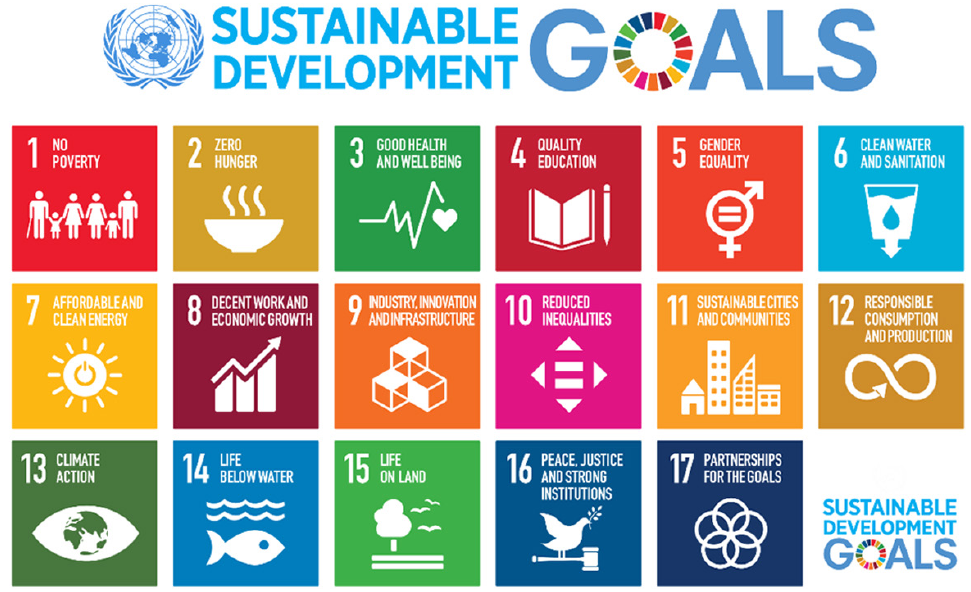
Fig. 1. Sustainable Development Goals